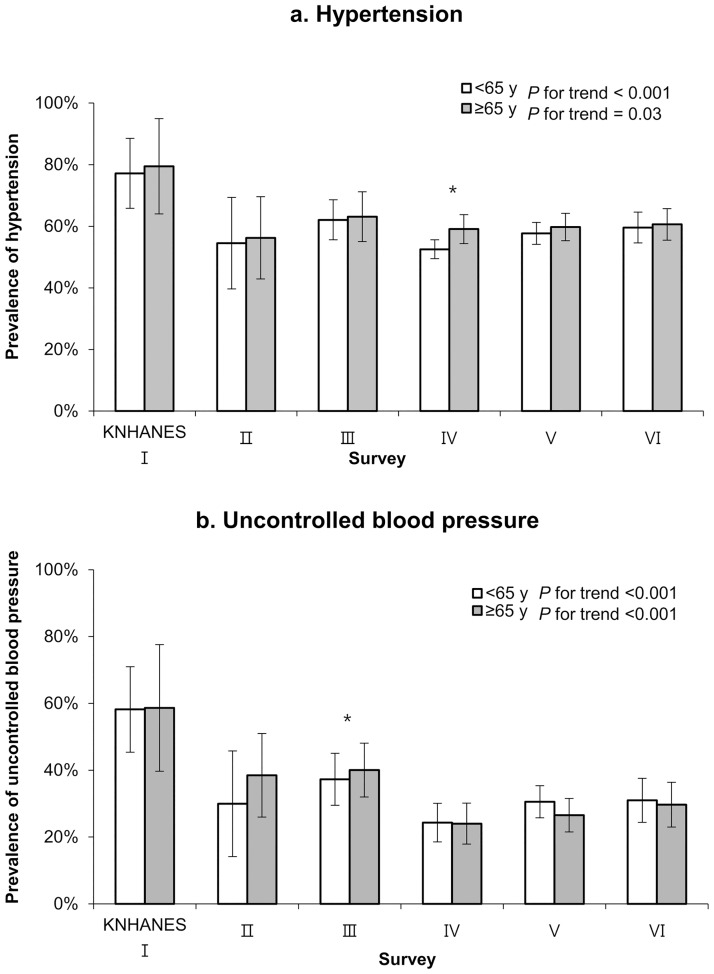
The prevalences of uncontrolled blood pressure and hypertension among patients with diabetes mellitus according to age group and survey period.Values are adjusted for sex, medication use, smoking status (current smoker, previous smoker, or never smoker), alcohol consumption (<1 vs. ≥1 drink/day for women or <2 vs. ≥2 drinks/day for men), body mass index (<23 kg/m2 or ≥23 kg/m2), education level (less than high school or more than high school), duration of diabetes, and psychosocial stress. *p < 0.05.